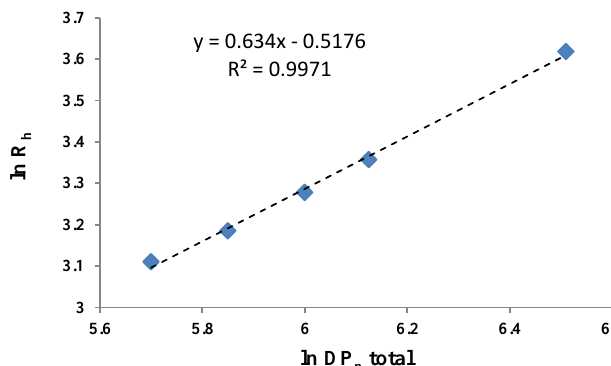
Figure 7. Logarithmic variation of the R h as a function of DP n total of PB-P2VP-PEO triblock terpolymers in n -heptane [88].